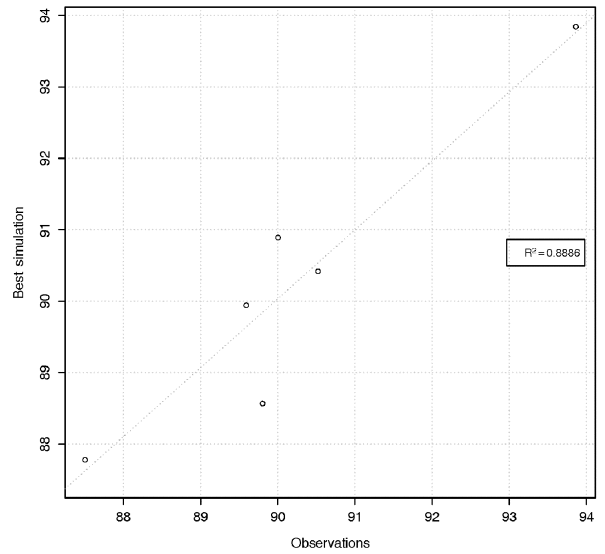
Figure 2. Scatter plot with the experimentally observed and calcu- lated values of uranium carbonate (sorption percentage).